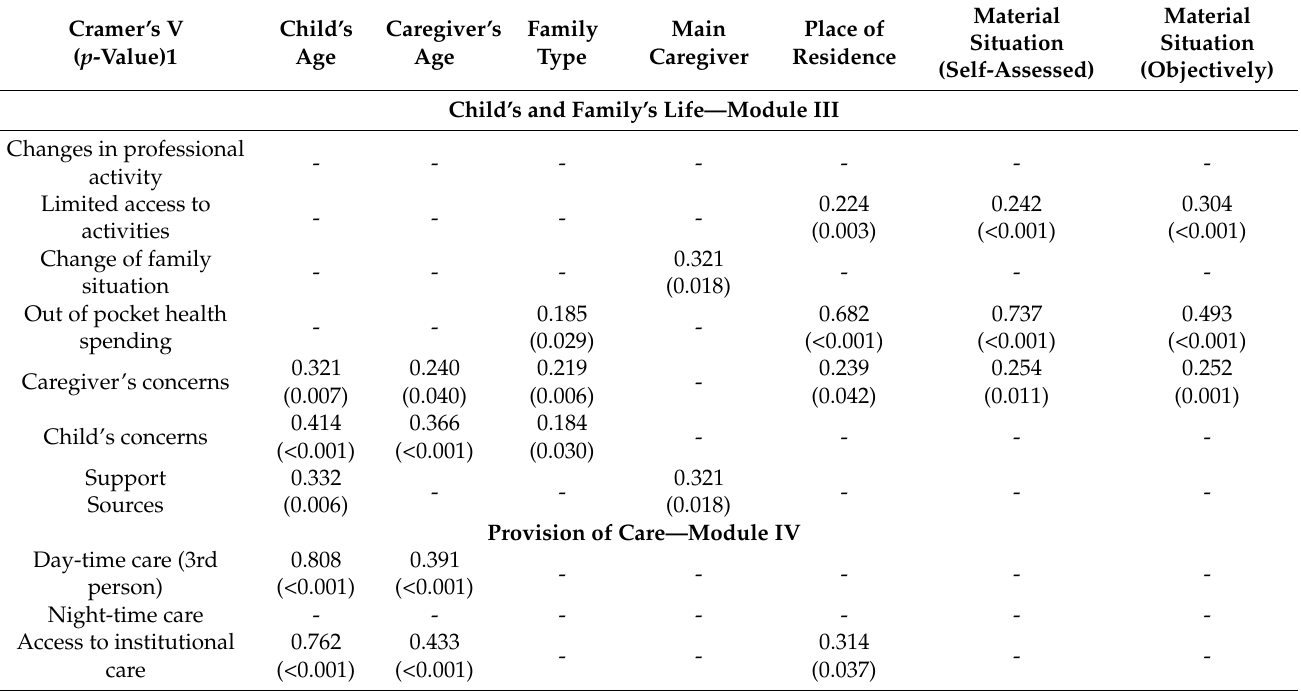
Table 3. Influence of demographic